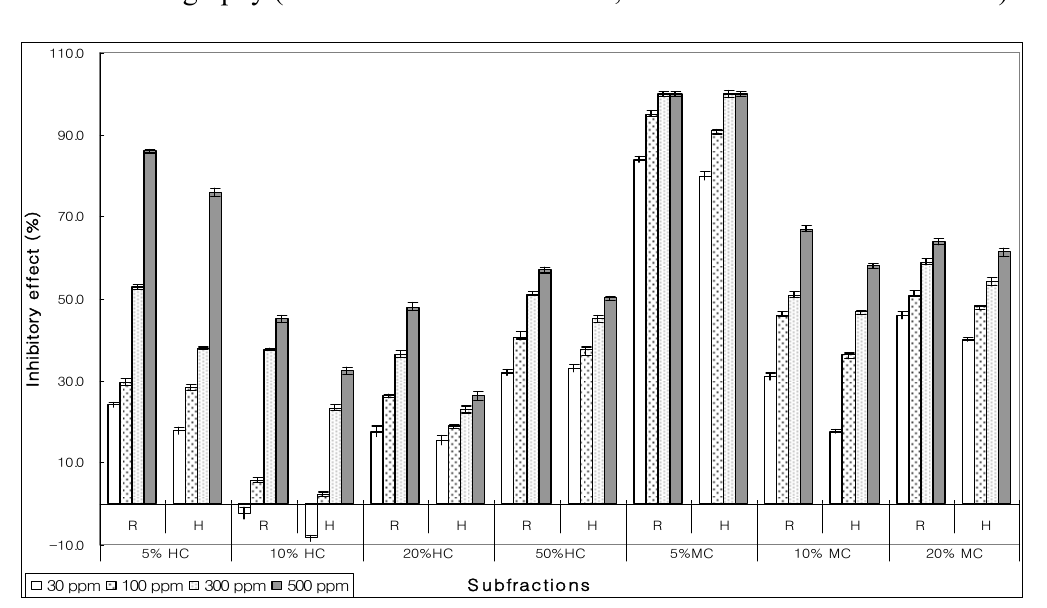
Figure 3. Allelopathic behavior of various subfractions on the growth of root (R) and hypocotyls (H) of lettuce seed derived from bioactive hexane extract using silica gel column chromatography (HC – hexane in chloroform; MC – methanol in